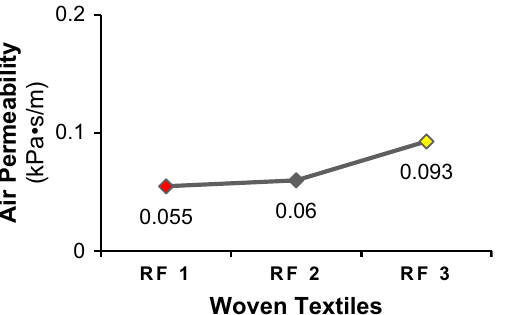
Fig. 13 Air resistance (kPa s/m) of the woven textiles with different weave structures. RF Reflective ·